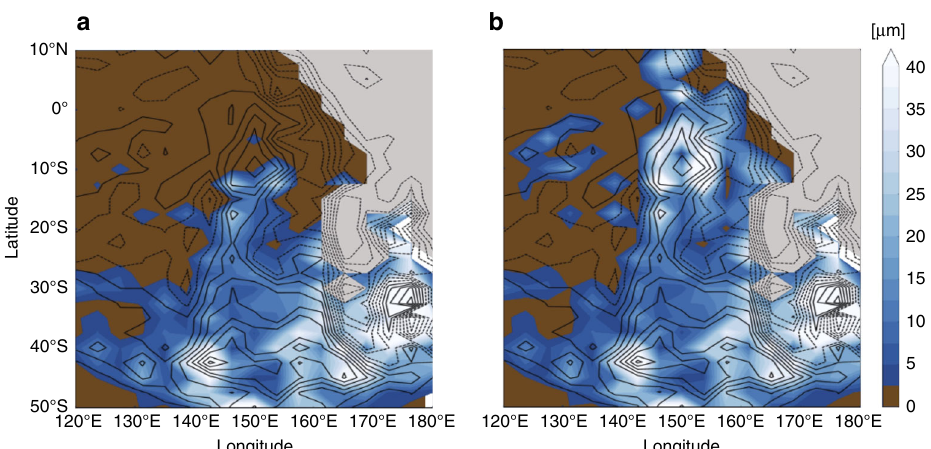
Fig. 2 Modelled deposition of CH 4 ice in eastern Cthulhu. a Net surface CH 4 ice accumulation (from blue to white) in Cthulhu (covering the same area as in Fig. 1a) obtained in our simulation for 2015. Superimposed topography contours are at 300-m intervals. The volatile-free surface is shaded in brown, the Sputnik Planitia N 2 ice sheet is shaded in grey. b The same as ( a ) but using an amplifying albedo feedback for CH 4 ice (see ‘ Methods ’ , Surface albedo feedback for equatorial CH 4 ice). The albedo feedback has no effect below ∼ 20°S because these latitudes receive little to no insolation (polar night) in